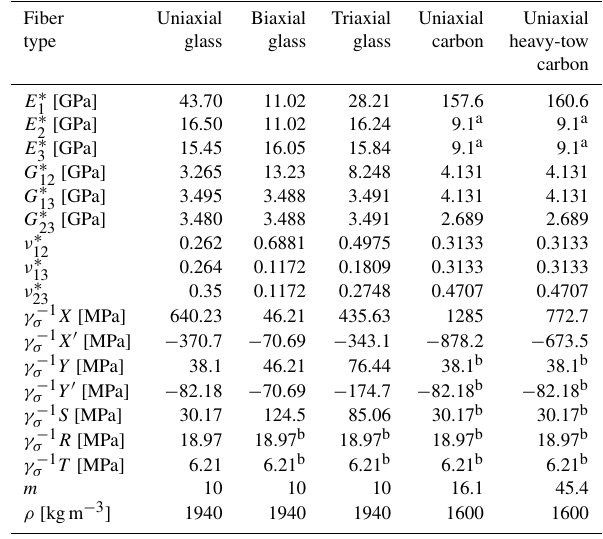
Table 1. Mechanical properties of composite laminates by fiber type. All strength properties are design values (not the character- istic values) and are obtained with γ σ = 1 . 74.